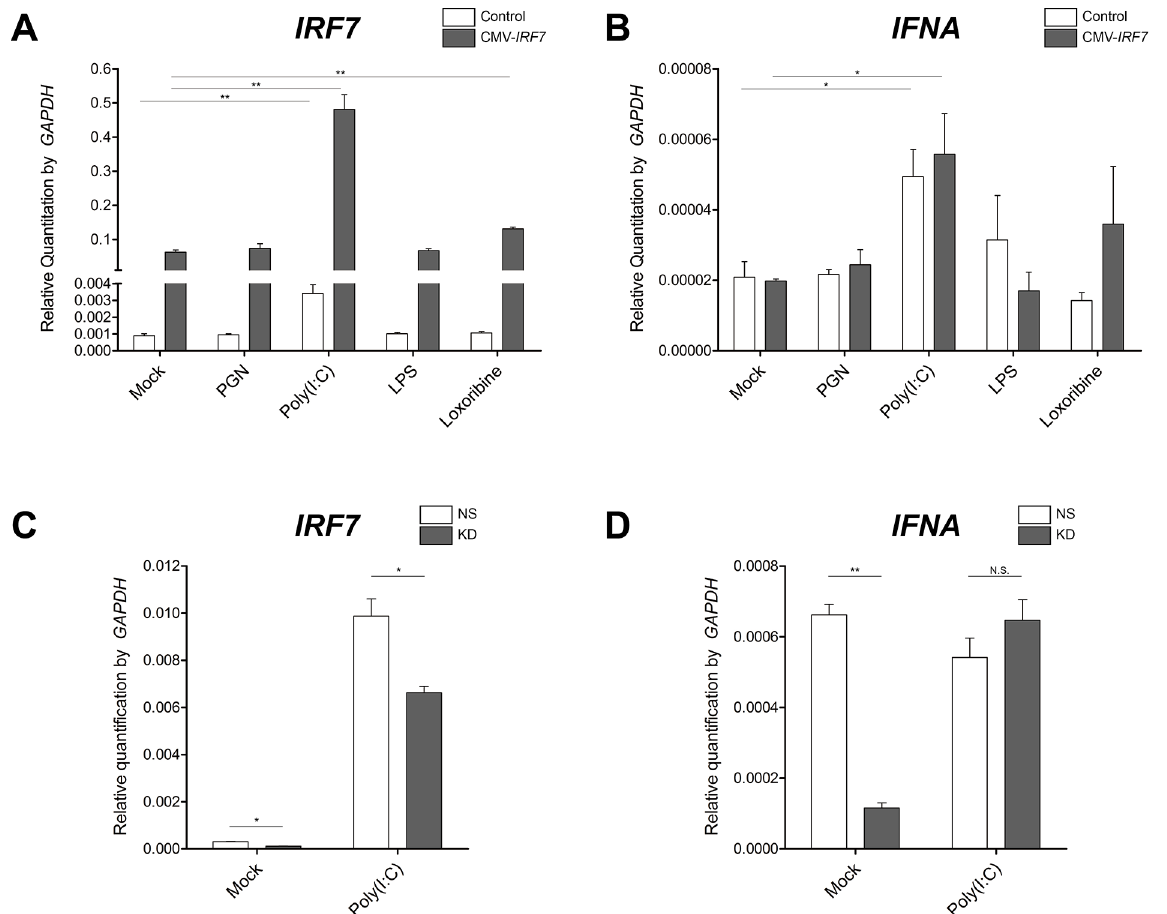
Fig 2. Expression changes of IRF7 and IFNA in response to different pathogen associated molecular patterns (PAMPs) stimulated cell lines. (A, B) IRF7 overexpression (CMV-IRF7) or (C, D) knockdown (KD) DF-1 cell lines and their respective control lines at 6h post stimulation by PAMPs. Mock: media (negative control); PGN: peptidoglycan; poly(I:C): polyinosinic-polycytidylic acid; LPS: lipopolysaccharide. * P < 0.05, ** P < 0.01. Error bars indicate the SEM of triplicate